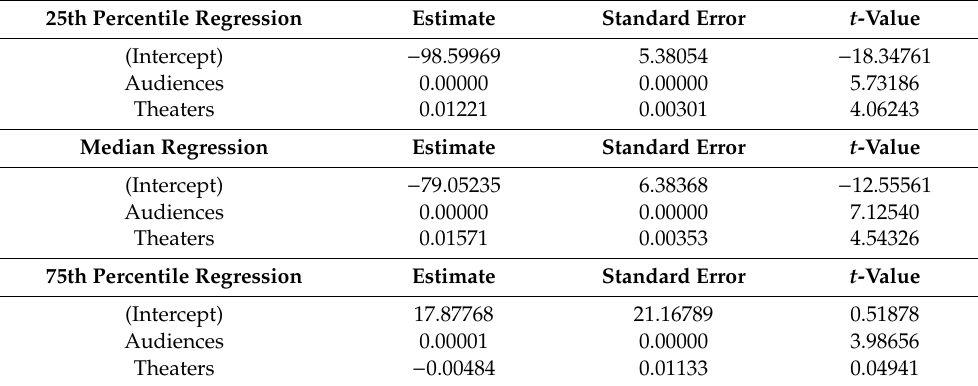
Table 8. Quantile Regression of ROI with 2010–2014 Years data.